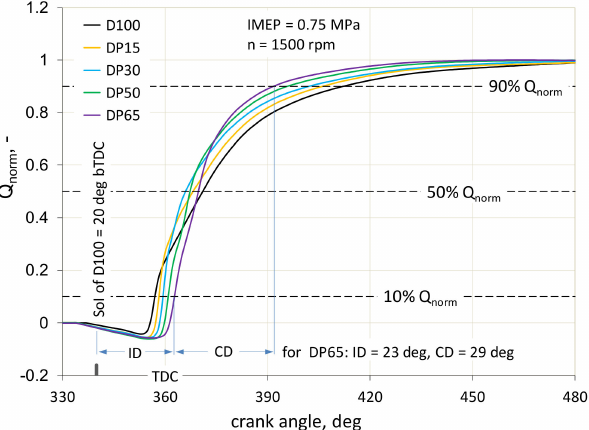
Figure 5. Normalized heat release (Q norm ) characteristics for dual-fuel engine fueled by diesel and propanol with alcohol content from 0 to 65%.